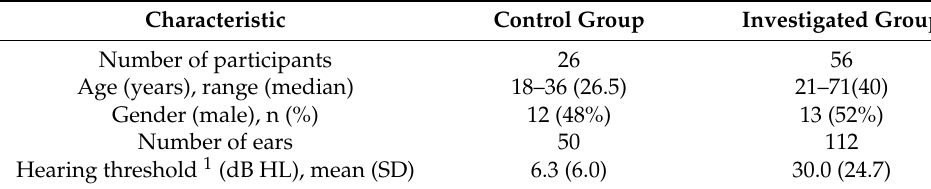
Table 1. Baseline demographic data.